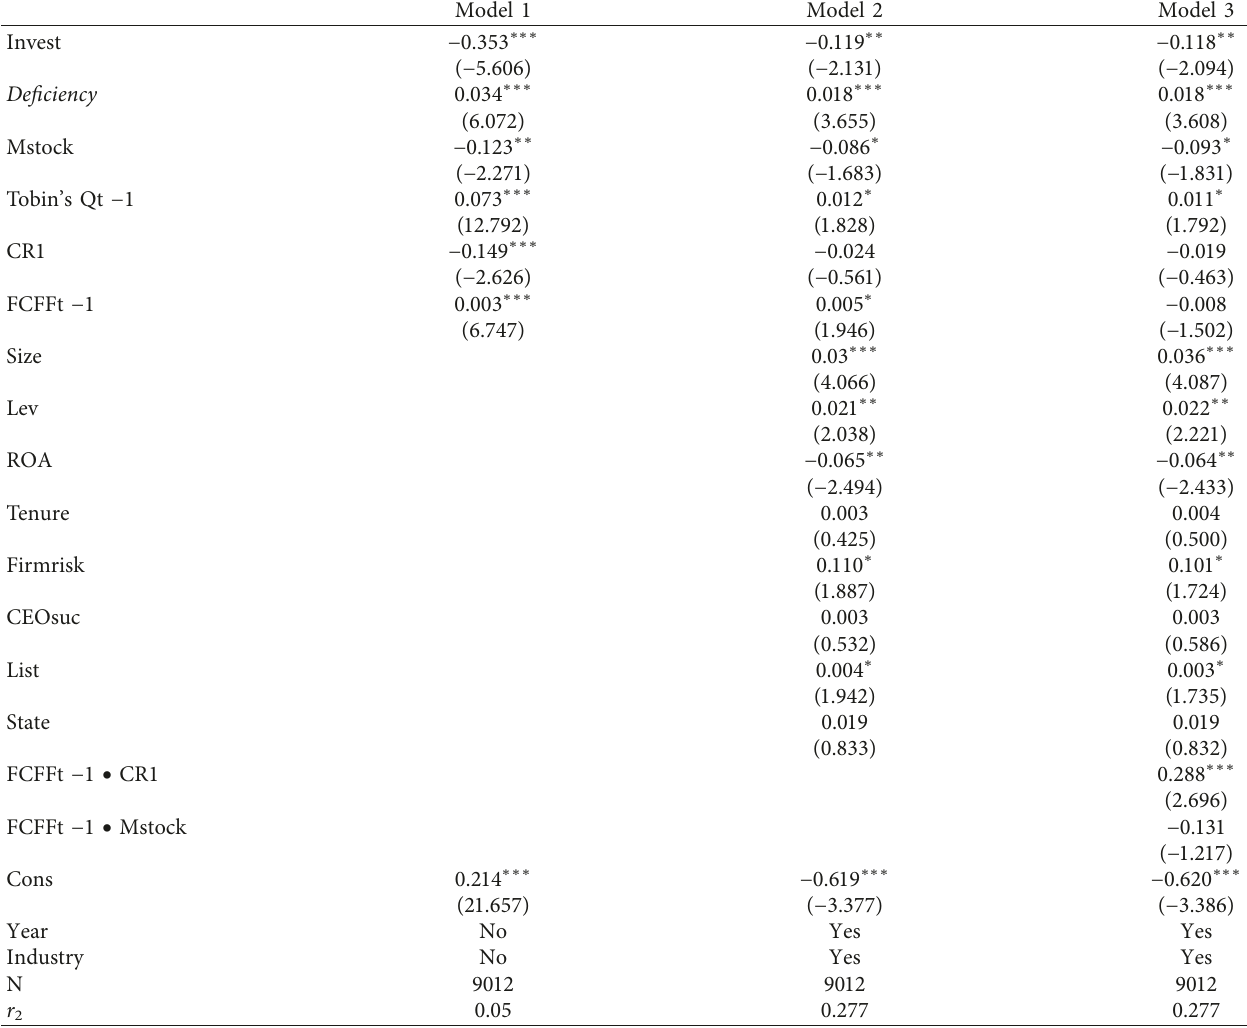
Table 5: Regression analysis results of internal capital allocation efficiency and diversification degree.